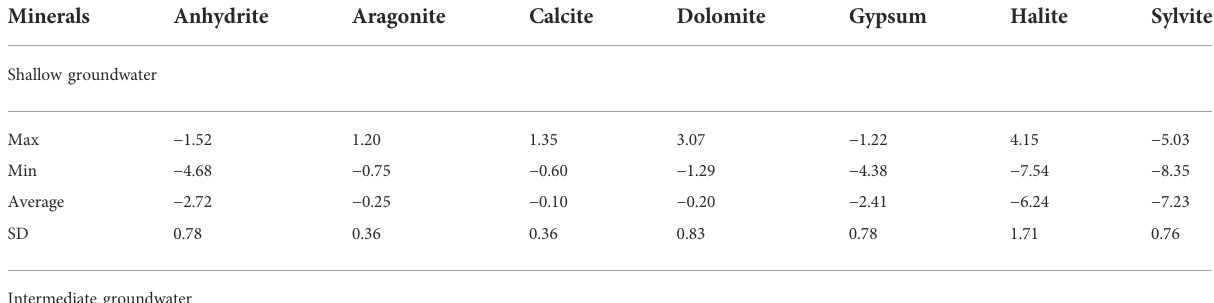
TABLE 2 Statistical summary of the mineral saturation indices of the studied groundwater. Minerals Anhydrite Aragonite Calcite Dolomite Gypsum Halite